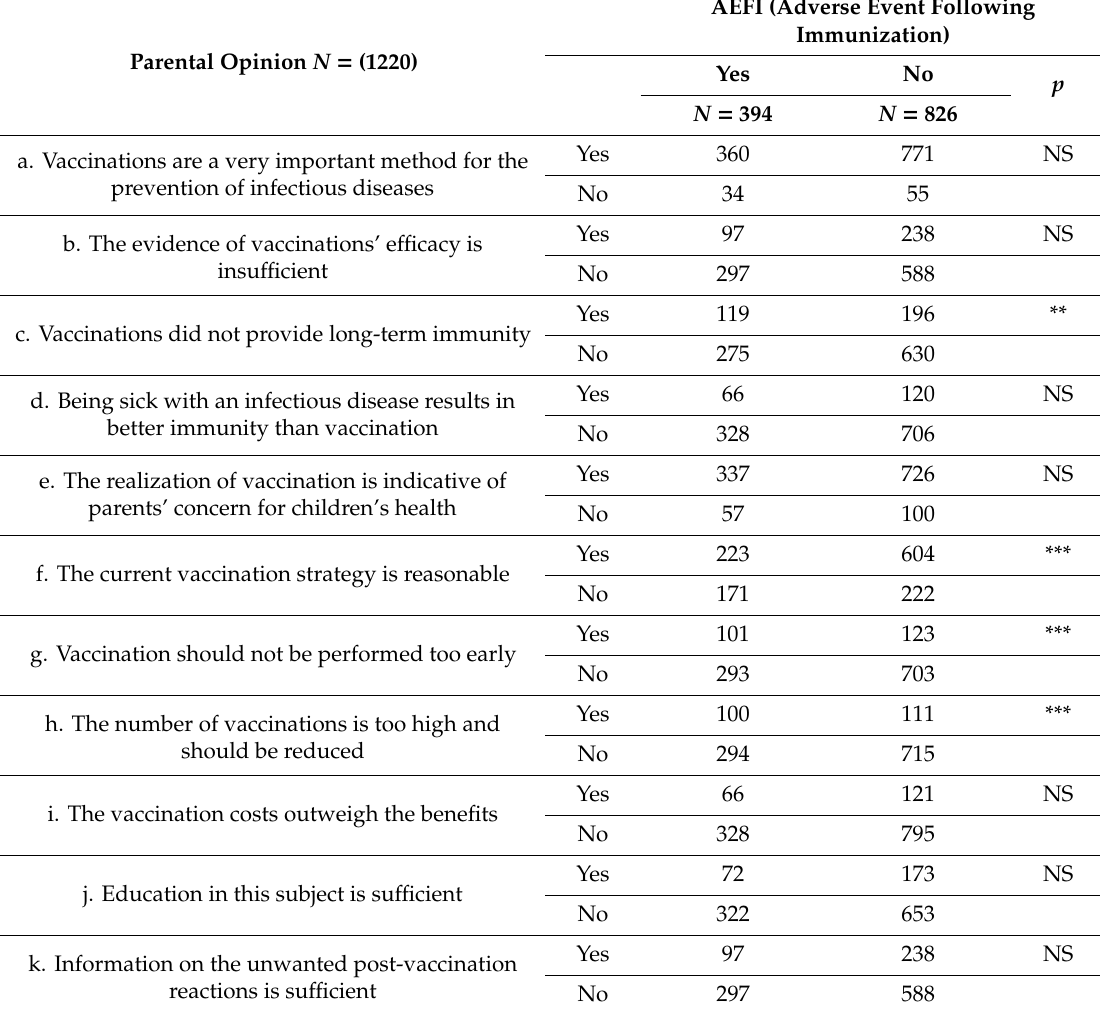
Table 2. Parental opinion according to the reported adverse event following immunization.